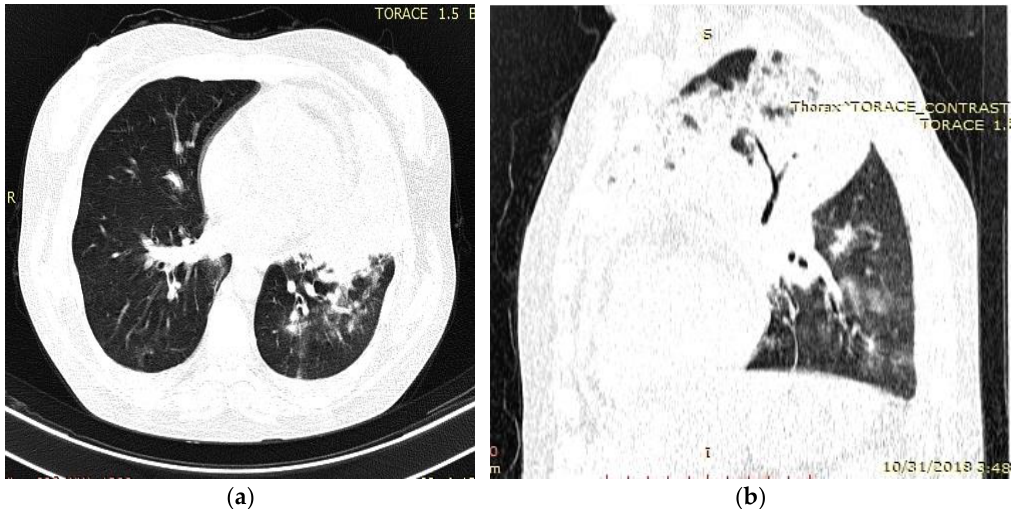
Figure 2. Chest computed tomography (CT) findings (October 2018): axial ( a ) and sagittal ( b ) lung window settings showed massive inhomogeneous consolidation in the entire left upper lobe, with air bronchogram identification. Mild pericardial effusion, and few alveolar opacities in left, lower, and middle lobes.